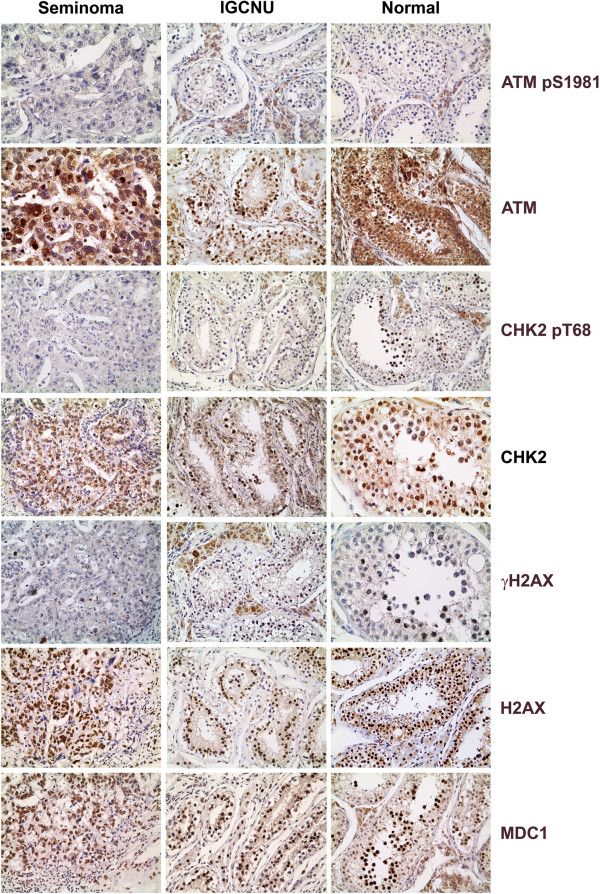
Immunohistochemical staining for the DDR molecules in seminoma, IGCNU and normal testis. pS1981-ATM, pT68-CHK2, γH2AX and MDC1 show weak to absent, focal nuclear positivity. Immunostaining for ATM, CHK2 and H2AX shows a strong nuclear reactivity in all the samples. Magnifications are 250× for pS1981ATM and ATM in seminoma, 200× for CHK2 and γH2AX in normal trestis, 150× for the remaining.